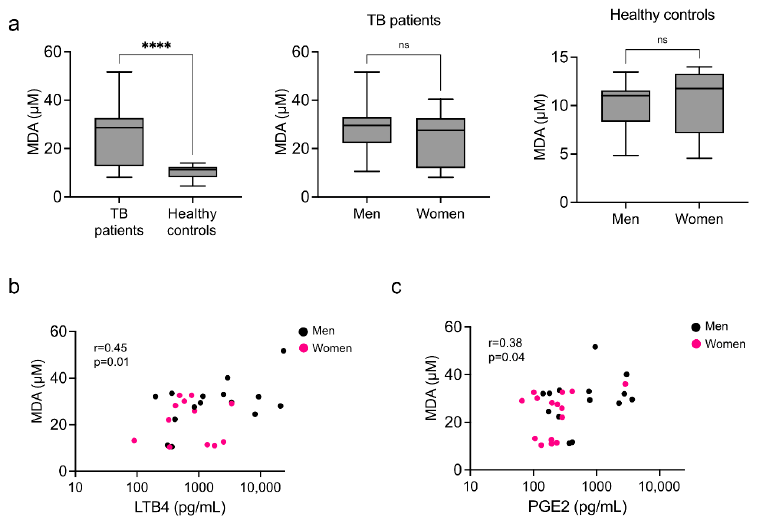
Figure 6. Circulating levels of malonaldehyde (MDA). Serum levels of MDA were measured in pa- tients with pulmonary tuberculosis and healthy controls by ELISA ( a ). Box plots with medians and quartiles are depicted ( left ). Data were disaggregated by sex for both the patients ( center ) and con- trols ( right ). **** p < 0.0001, ns = not significant. Correlation plots for MDA and pro-inflammatory eicosanoids, LTB4 ( b ) and PGE2 ( c ) are depicted. Spearman’s rho with p values are included within the plots.